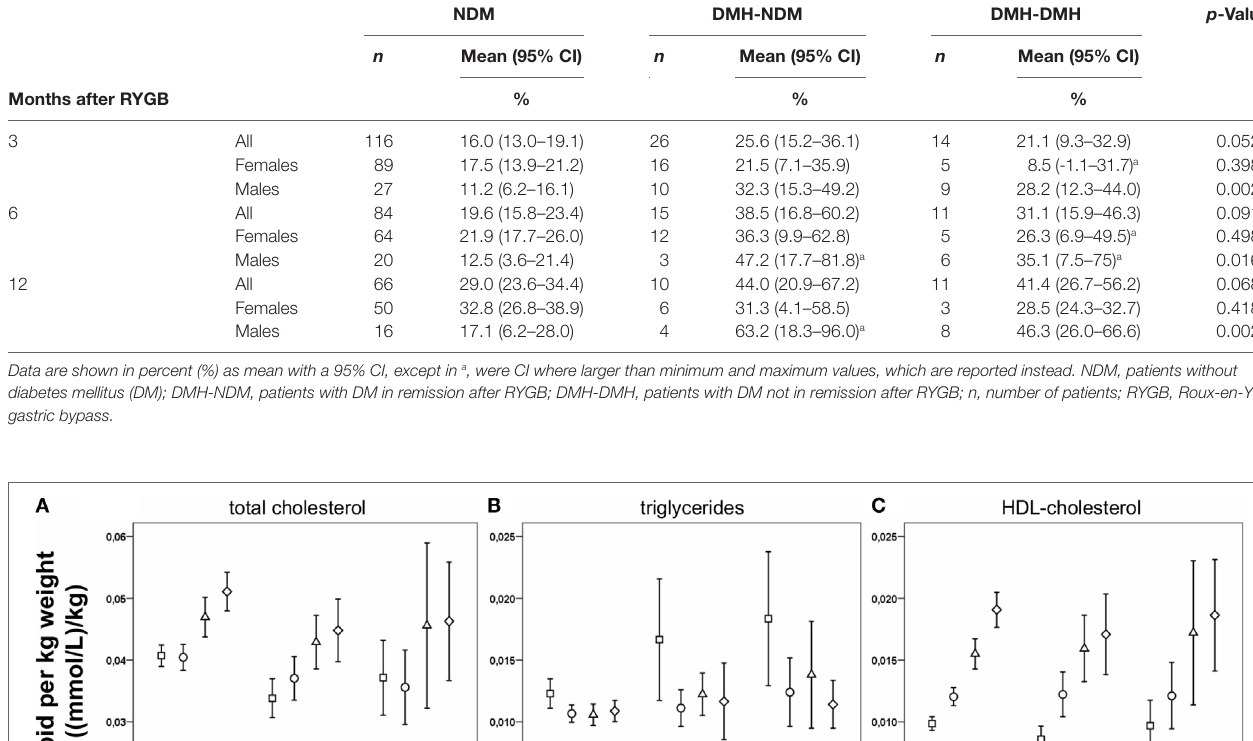
TaBle 2 | Relative percentage increases in sphingomyelin concentration per kg bodyweight at 3, 6, and 12 months after RYGB surgery.